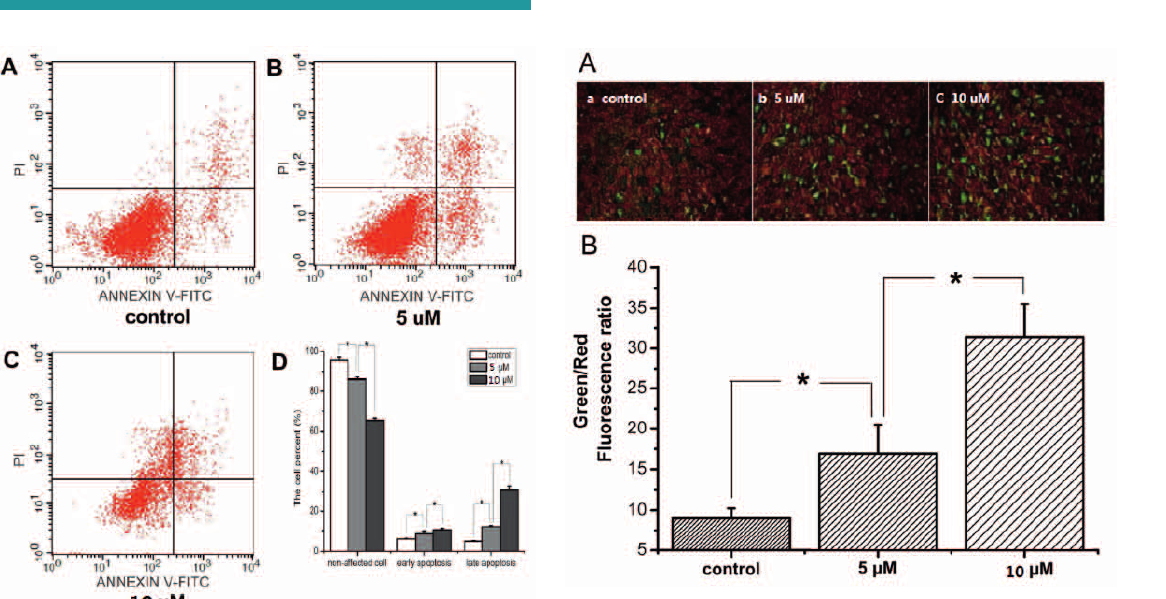
Figure 4. Effects of scutellarein on the ΔΨ m of human tongue cancer SAS cells. SAS cells were treated with scutellarein (5, 10 µM) for 96 h and stained with JC-1 probe and im- aged by a fl uorescent microscope. The individual red and green average fl uorescence intensities are expressed as the ratio of green to red fl uorescence. The increase of fl uo- rescence ratio, which is represented in the bars, is corre- lated with an increase in mitochondrial depolarization a-c. representative photographs of JC-1 staining in different groups. Quantitative analysis of the shift of mitochondrial green fl uorescence to red fl uorescence among groups. All values are denoted as mean ±SEM from ten independent photographs shot in each group. *P<0.05 compared with each